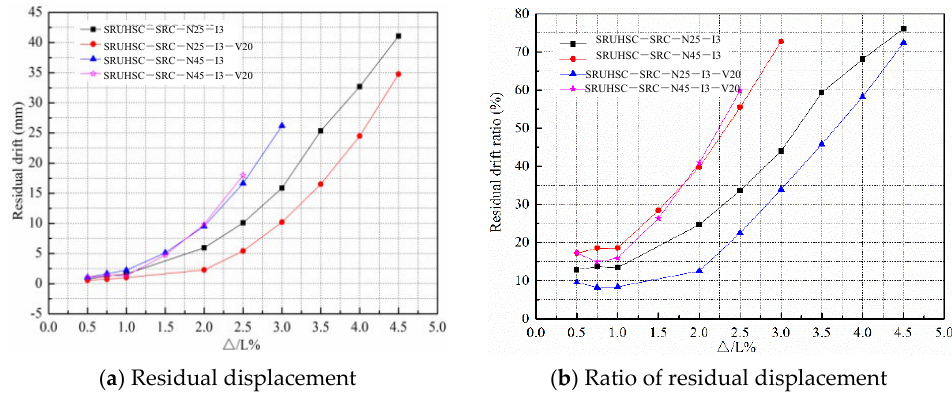
Figure 10. Residual deformation curves.